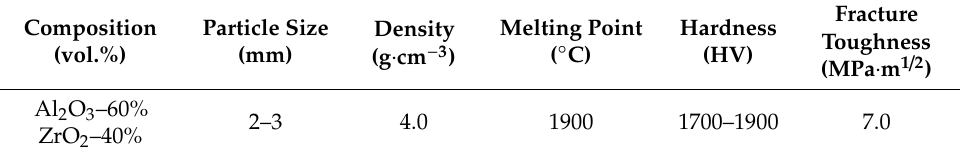
Table 1. The physical and mechanical properties of the ZTA (ZrO 2 –toughened Al 2 O 3 ) particles. Composition